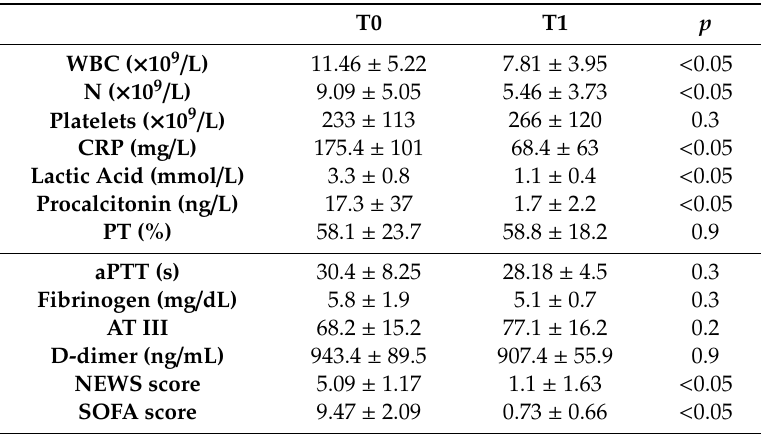
Table 2. Clinical findings over time in patients with sepsis.